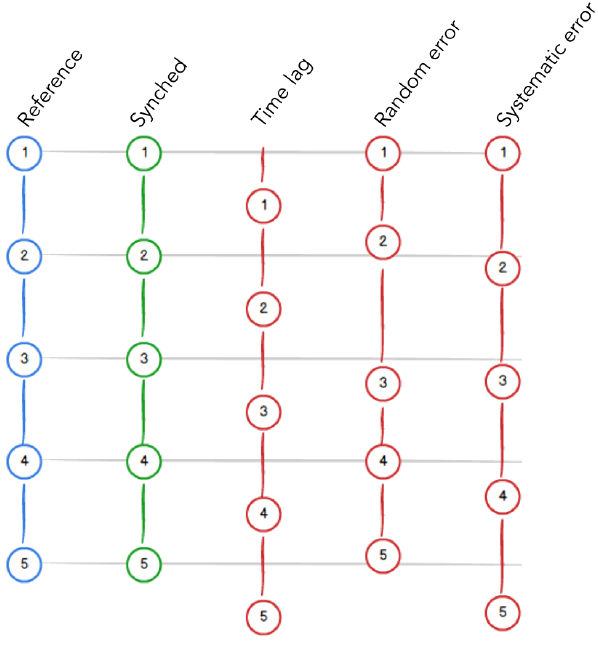
Figure 1. Schematic of the three types of misalignments common in EC data. Given a reference time series (e.g., w , blue), the ideal paired gas concentration time series is perfectly aligned (green). The three red time series exemplify (from left to right): a constant offset (time lag), random variations around the perfect alignment (random error), and a systematically larger time step (systematic er- ror). Real data are typically affected by a mix of all error types in varying